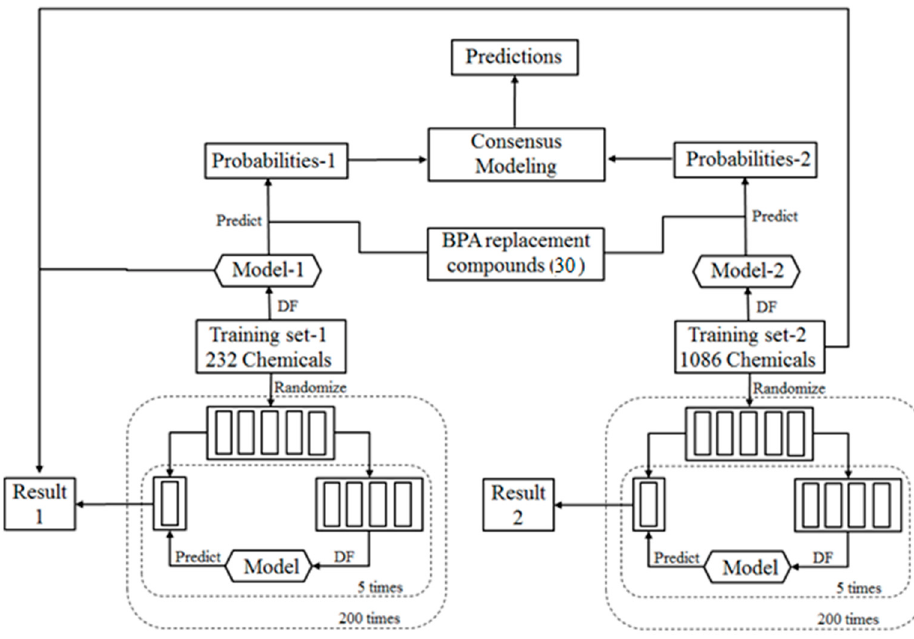
Figure 2. Workflow of the qualitative consensus modeling for prediction of compounds as estrogen receptor (ER) binders and non-binders.